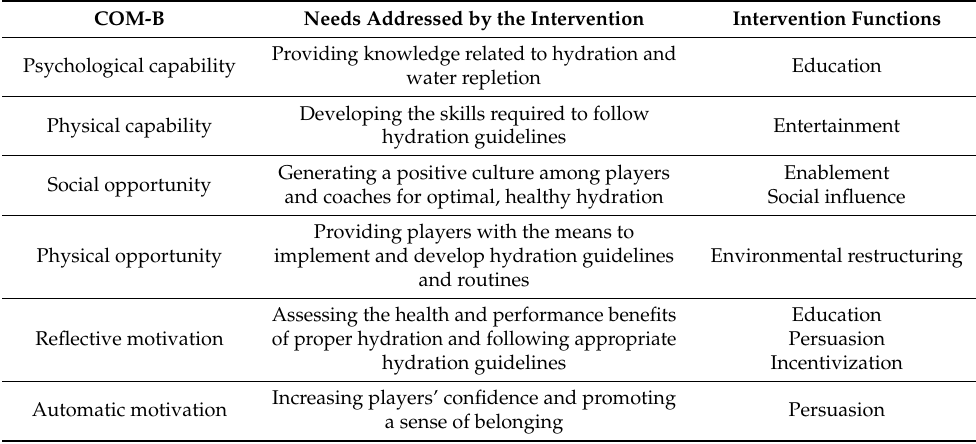
Table 1. Determinants, intervention functions, and needs included in the